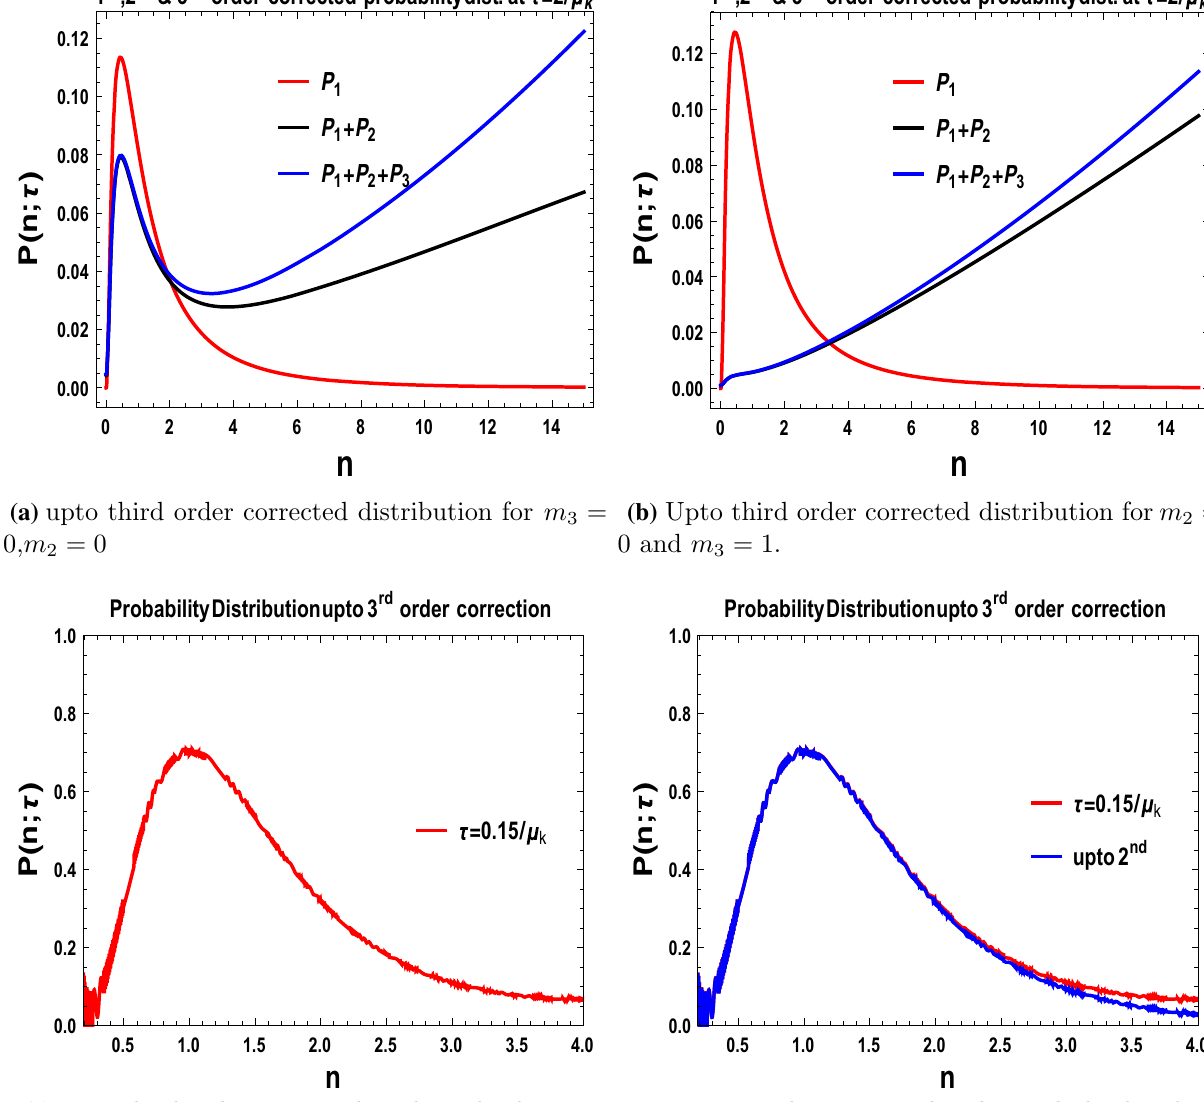
upto third order corrected analytical solution Fig. 46 Upto third order corrected probability distribution profile for different m 3 , m 2 and m 1 = 2 with previously mentioned initial conditions and Exact analytical solution for probability distribution with previous correction